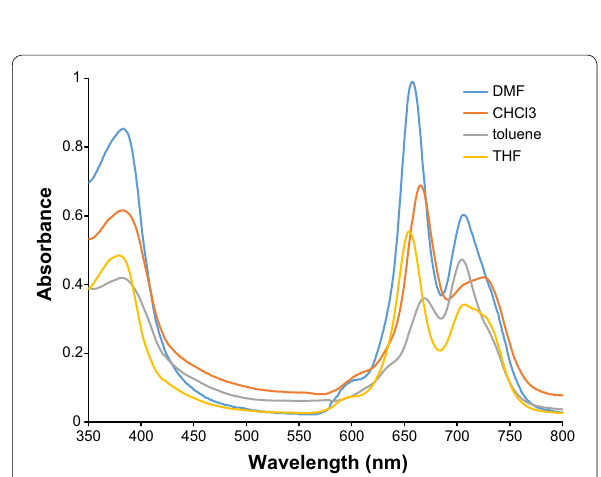
Fig. 2 UV–vis spectra of 4 in polar and non-polar solvents (20 mg l − 1 )